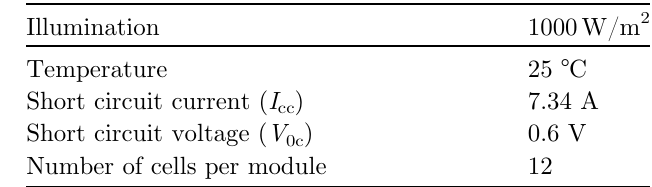
Fig. 2. Electrical model of photovoltaic cell.